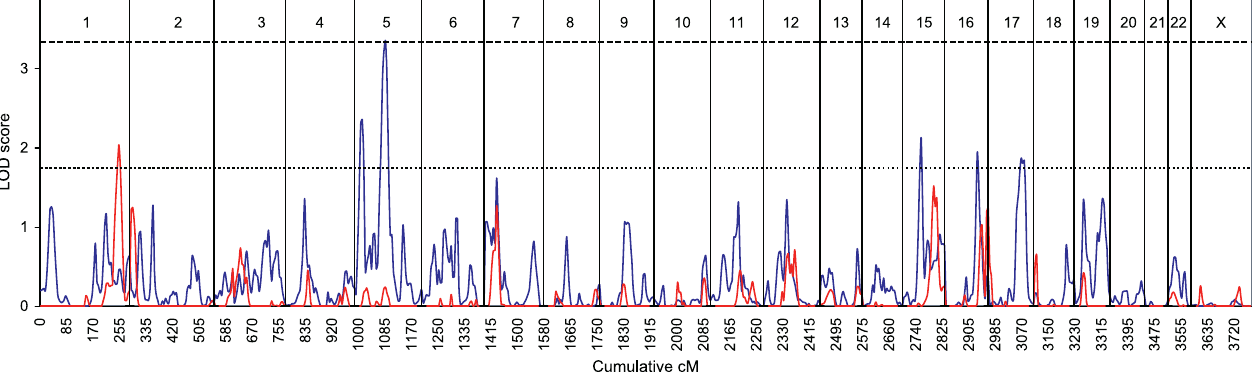
Figure 1. Results of Genome-Wide Univariate and Multivariate Linkage Analyses Results of univariate (red line) and multivariate (blue line) linkage analyses for absolute finger ridge count, showing empirical significant (dashed line) and suggestive (dotted line) thresholds for the univariate analysis obtained via simulation (1,000